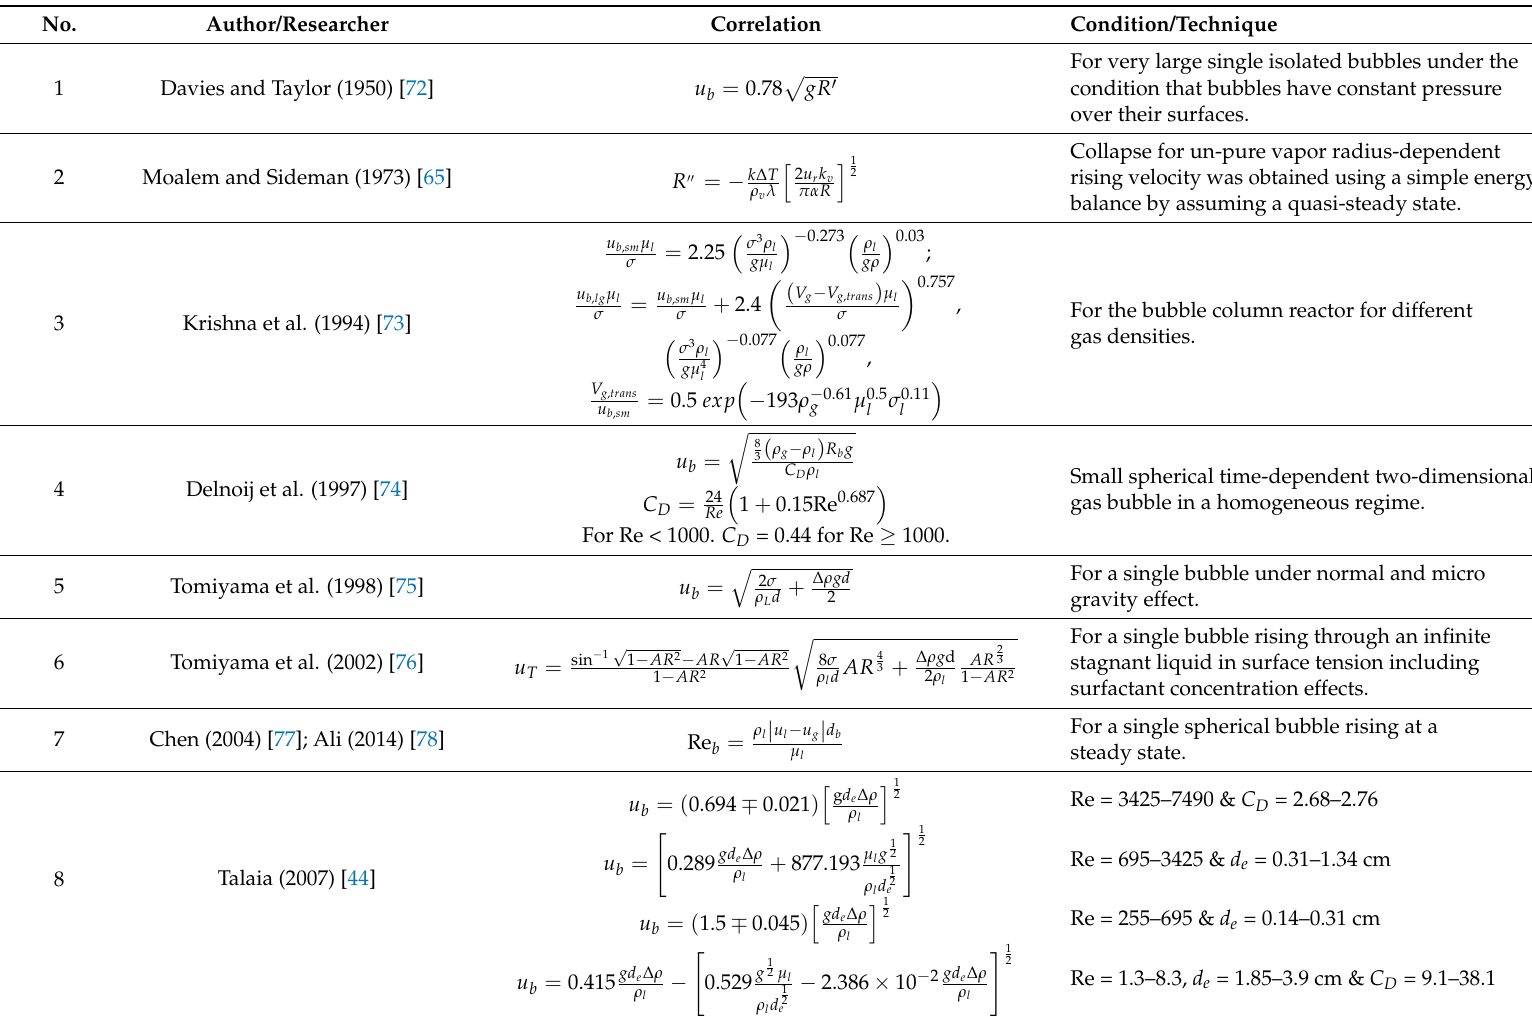
Table 2. Bubble rising velocity